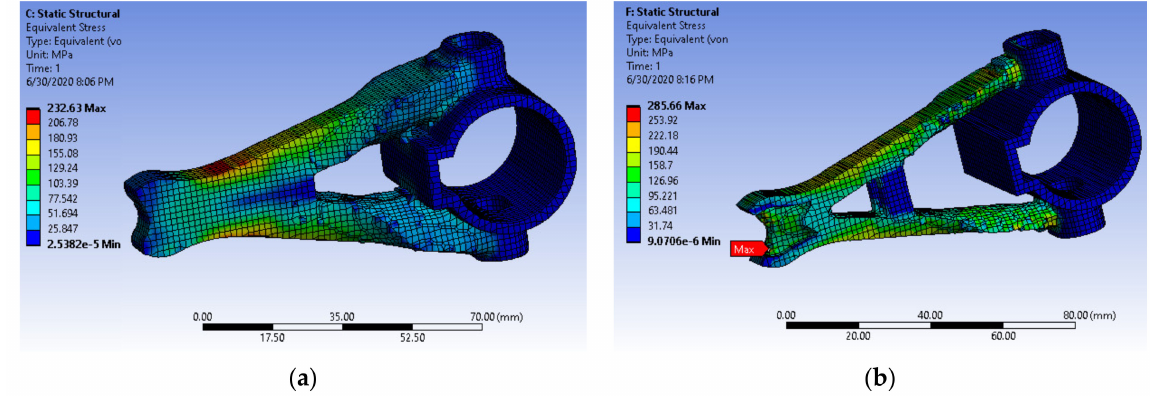
Figure 5. Resulting mesh and von Mises stress contours from the solid isotropic material with penalization (SIMP) method ( a ) and resulting mesh and von Mises stress contours from level-set method ( b ).